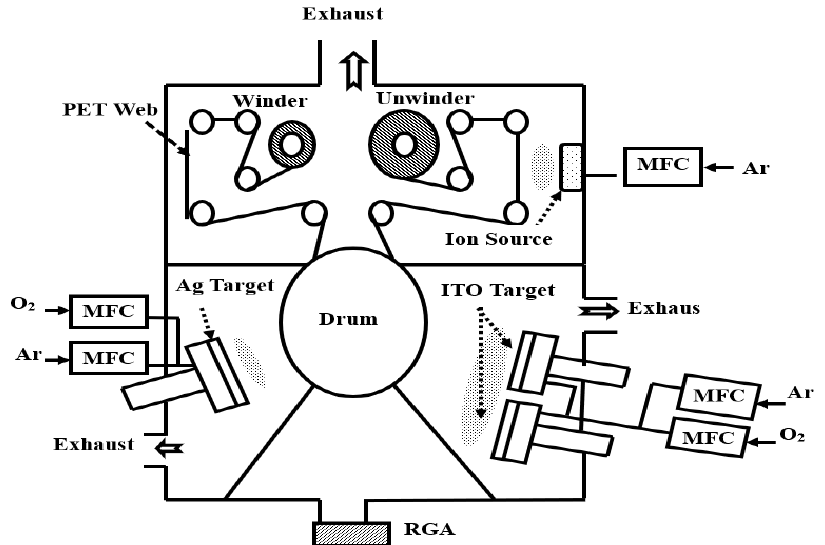
Figure 1. Schematic of roll-to-roll sputtering